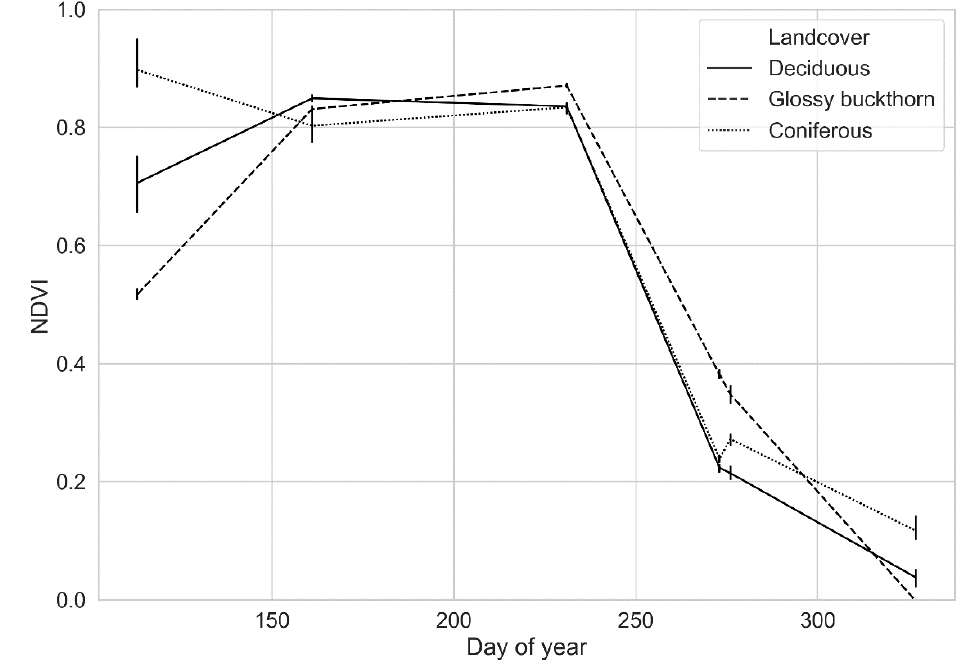
Figure A1. Landsat 8 OLI-derived NDVI phenological trajectories (i.e., temporal spectra) for the endmembers used in the unmixing procedure. Data points are mean NDVI values for groups of pixels extracted around each endmember field plot and for each image acquisition date. The error bars represent standard deviation for the same dates and groups of points.